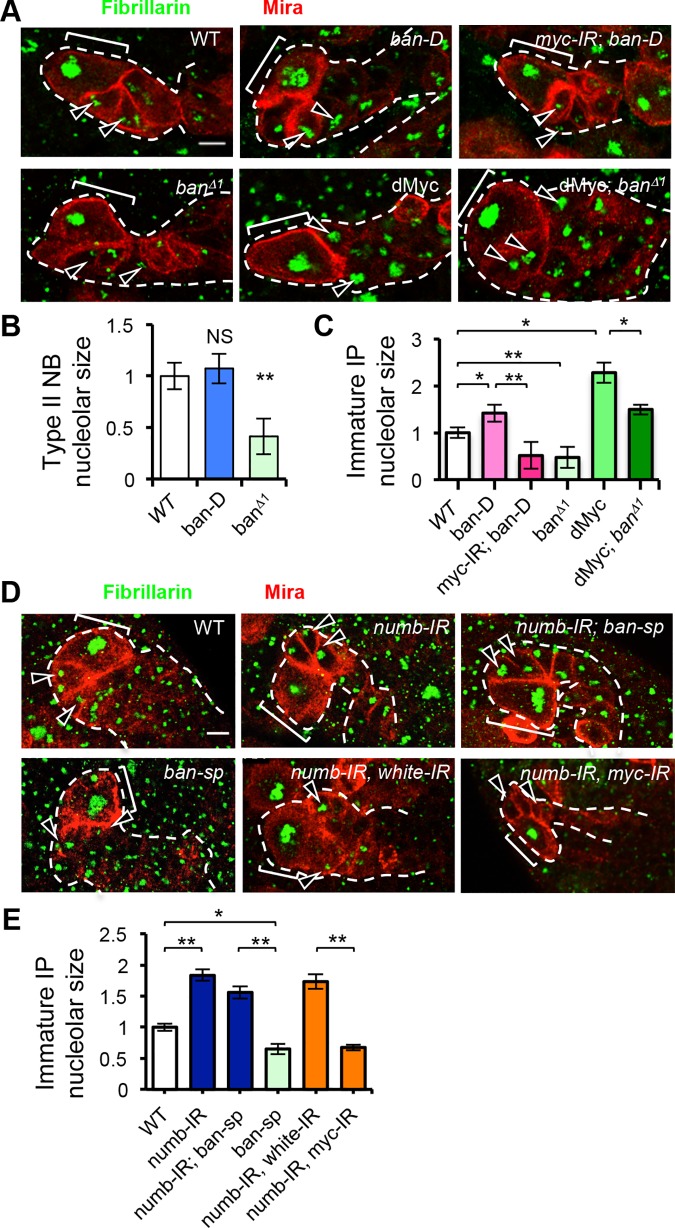
Regulation of nucleolar growth by ban and Numb in type II NB lineages.(A) Genetic interaction between ban and myc in nucleolar size regulation. Green, Fibrillarin; Red, Miranda; Bracket, NB. Arrowheads: nucleoli of immature IPs. (B) Quantification of effect on nucleolar size by ban GOF (ban-D OE) and ban LOF (banΔ1) in type II NBs from A. *, p< 0.005; NS, not significant; n = 10–12 type II NB lineages/genotype. (C) Quantification of nucleolar size of immature IPs in type II NB lineages from A. *, p< 0.001; **, P< 0.00001; n = 9–12 type II NB lineages/genotype. (D) Genetic interactions between Numb and ban and between Numb and Myc in nucleolar growth regulation. (E) Quantification of nucleolar size of immature IPs in type II NB lineages from D. *, p<0.001, **, p<0.00001; n = 8 type II NB lineages /genotype. Scale bars: A, D, 5 μm.